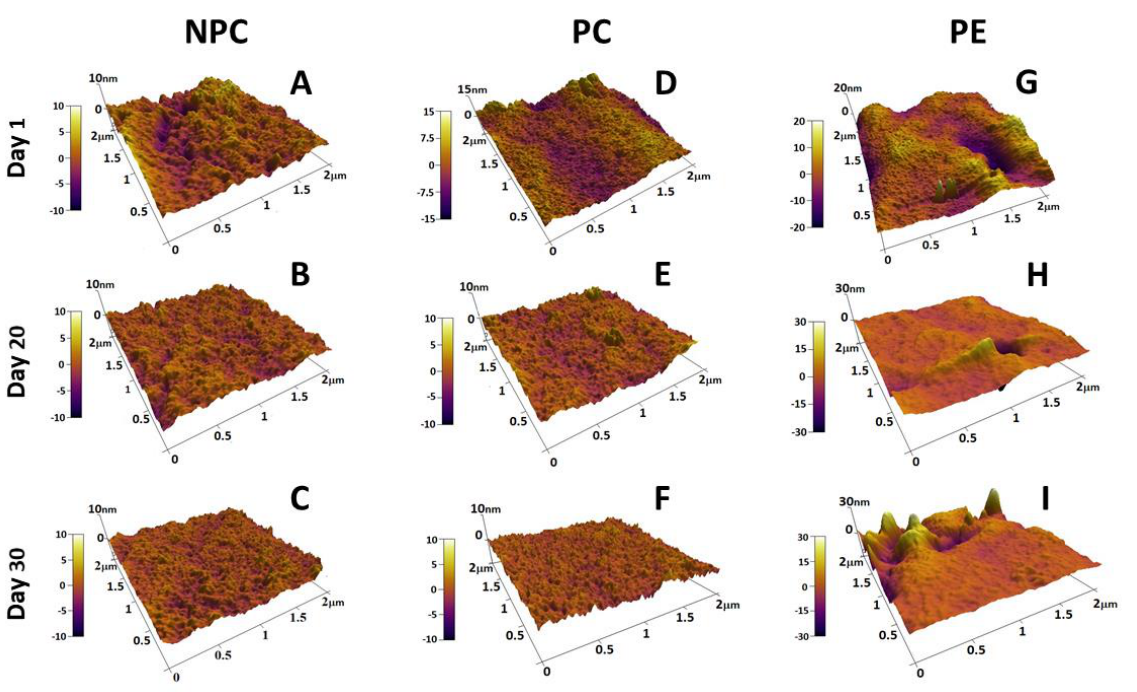
Figure 5. Selected 3D AFM images, representing the ultrastructural alteration of the membrane surface of RBCs isolated from patients with preeclampsia (PE ( G – I )), non-pregnant controls (NPCs ( A – C )), and pregnant controls (PCs ( D – F )) during the cells’ senescence. The scanned area is 2 × 2 µ m 2 . The membrane roughness as a function of the storage time for the two control groups decreased linearly. The R rms values of young RBCs derived from PCs and NPCs were close